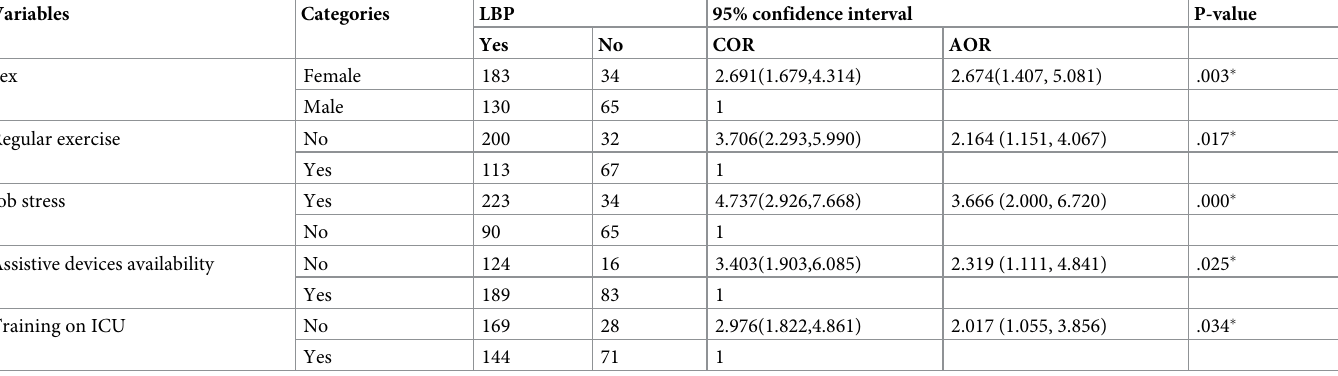
Table 3. Multivariable logistic regression analysis of factors associated with LBP among ICU nurses working at Amhara region public referral and general hospitals, 2020 (N = 382).